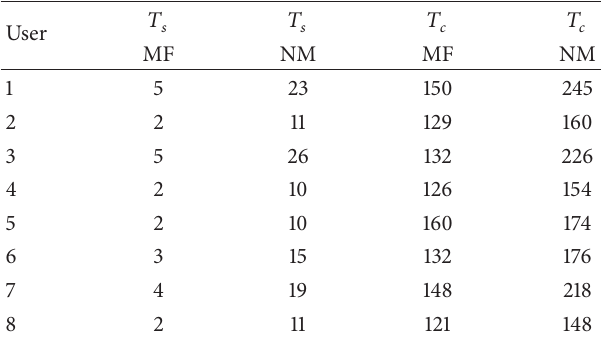
Table 2: Measured time-to-start ( 𝑇 𝑠 ) and time-to-complete ( 𝑇 𝑐 ) for users with disabilities. Mirror feedback (MF) and no-mirror feedback